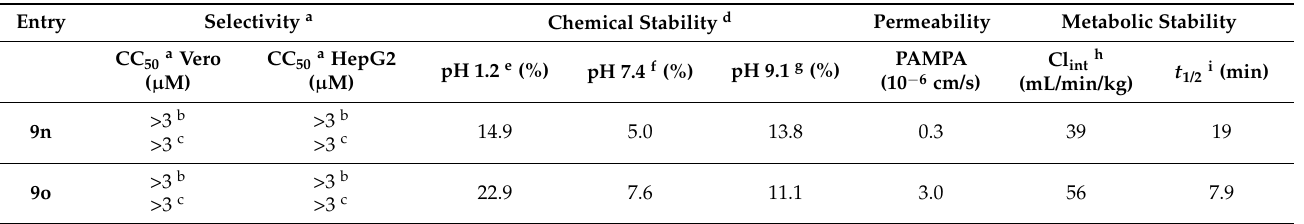
Table 2. Viability of Vero and HepG2 cells, chemical stability, permeability, and metabolic stability of 4-amino- N -(4-benzyloxy)quinolines 9n and 9o